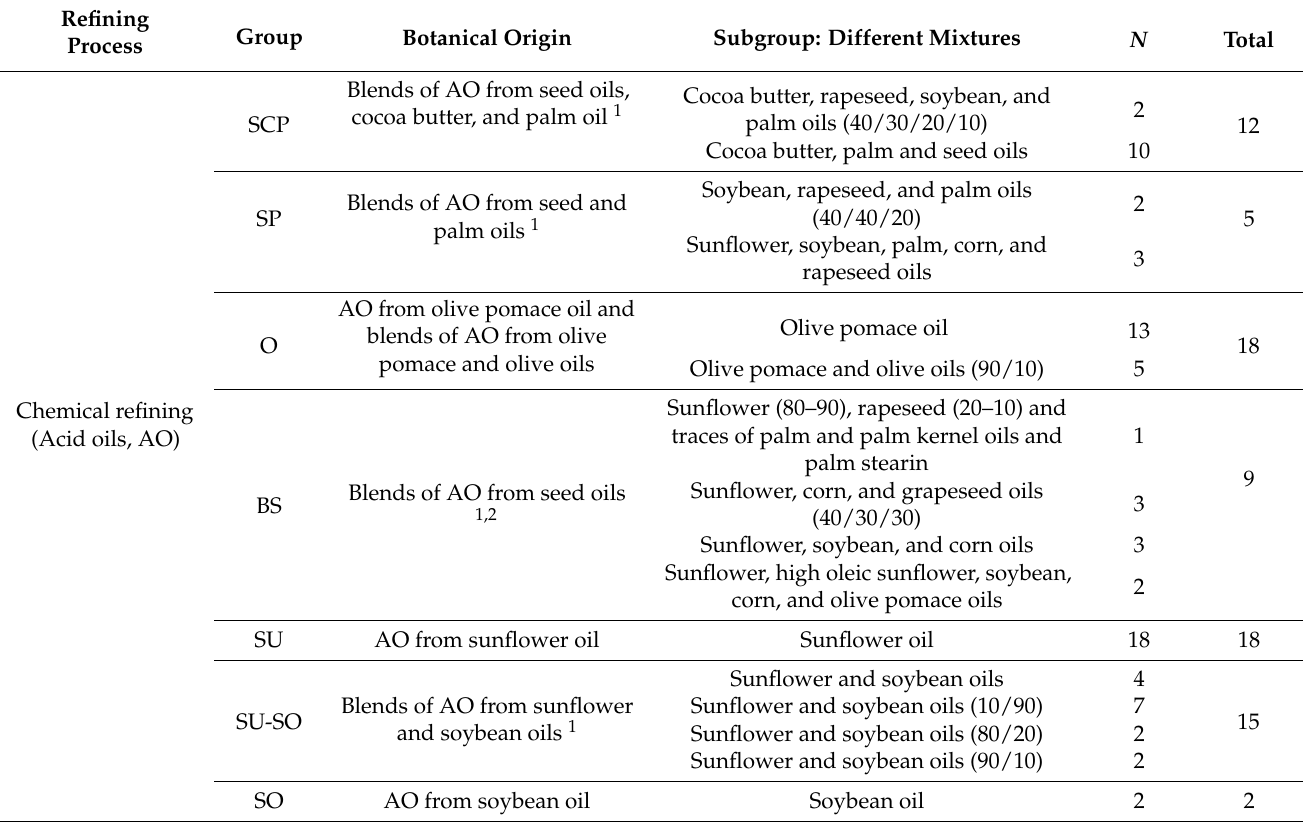
Table 1. Sample’s classification according to the refining process and botanical